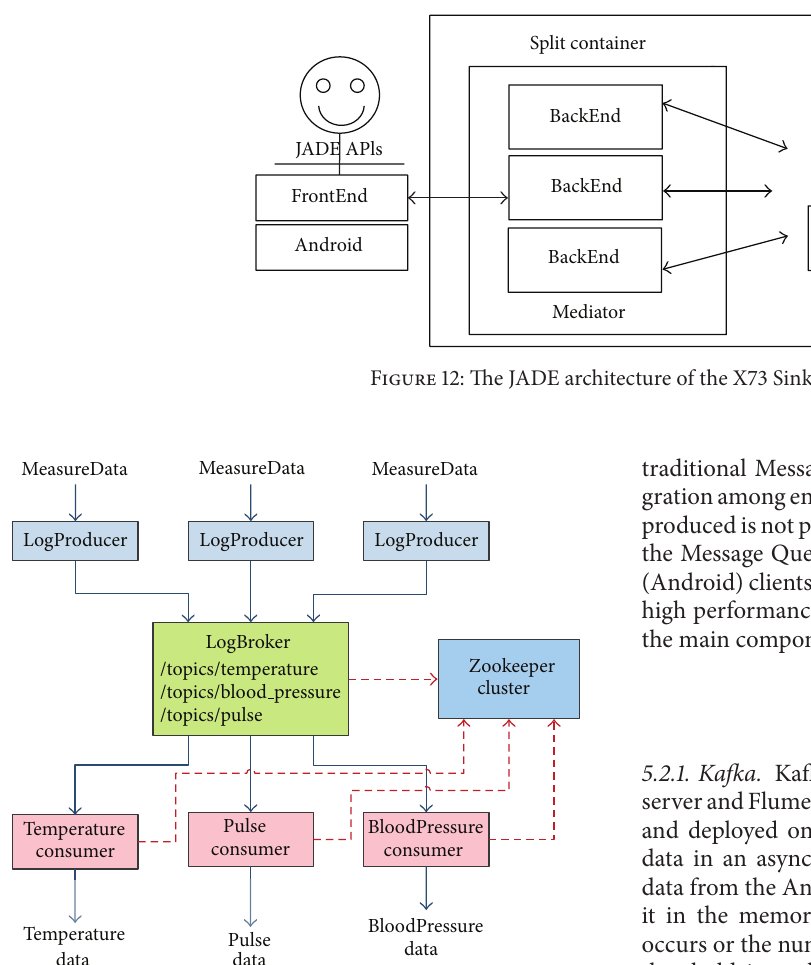
Figure 13: The use of Kafka in the X73 uHealth system.